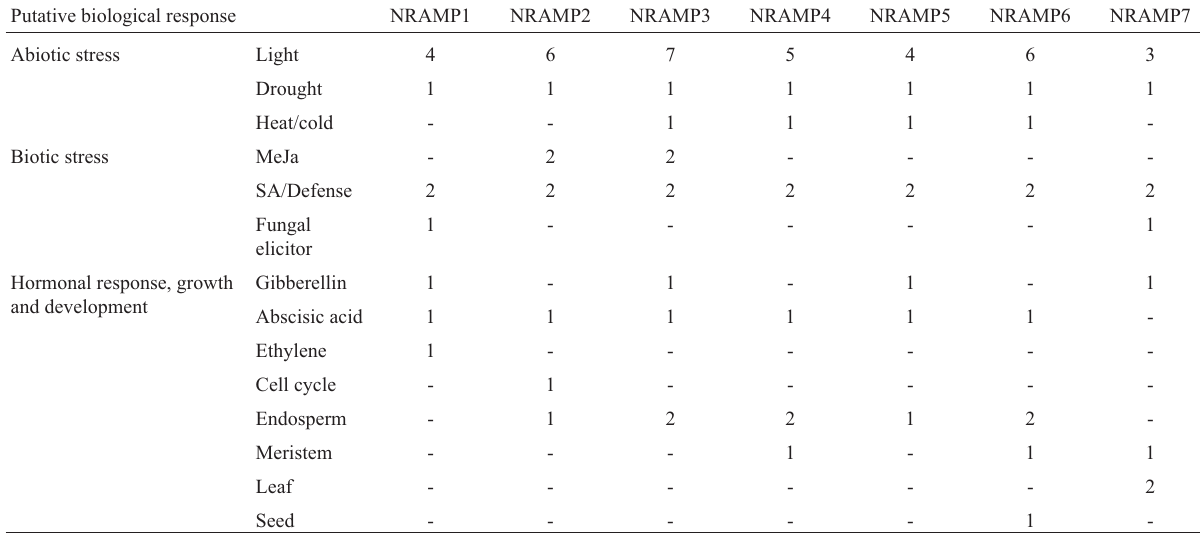
Table 2 - List of regulatory cis -elements identified in the putative promoter regions of seven NRAMP genes in P. vulgaris . Putative biological response